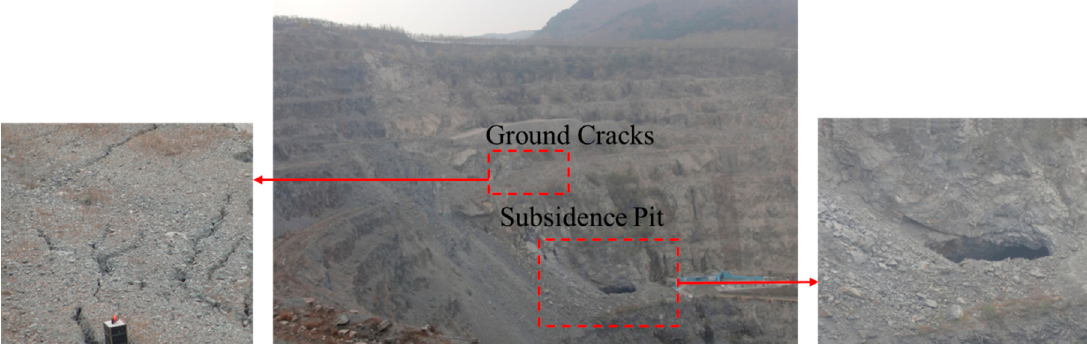
Figure 1. Subsidence pit observed at eastern final slope in Yanqianshan iron mine.